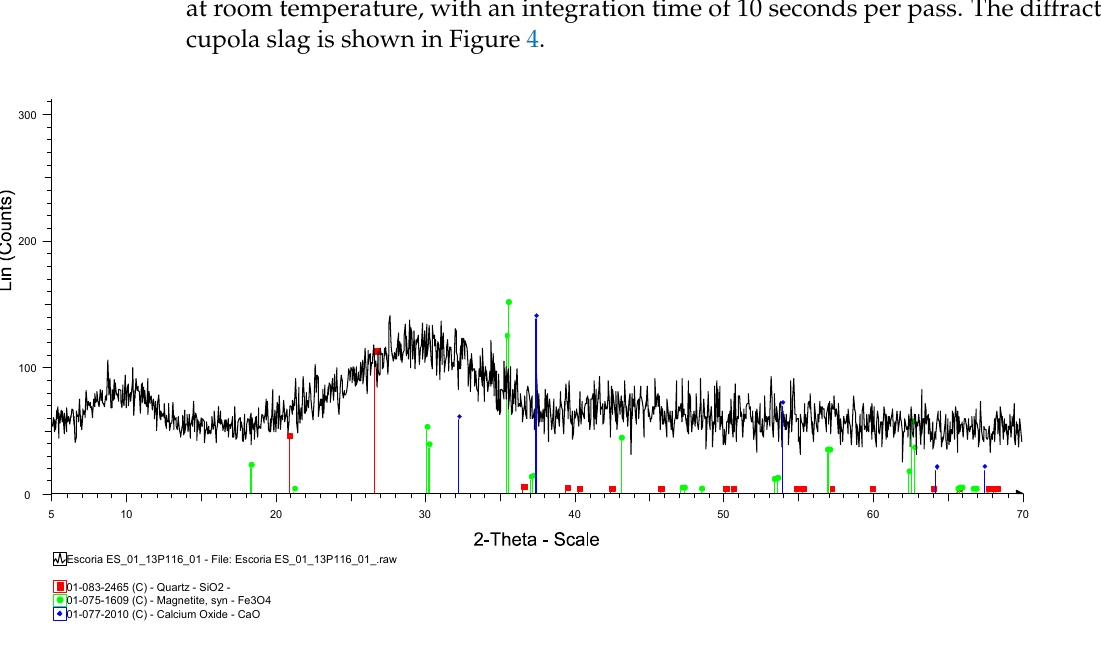
Figure 4. Diffractogram of the cupola slag.